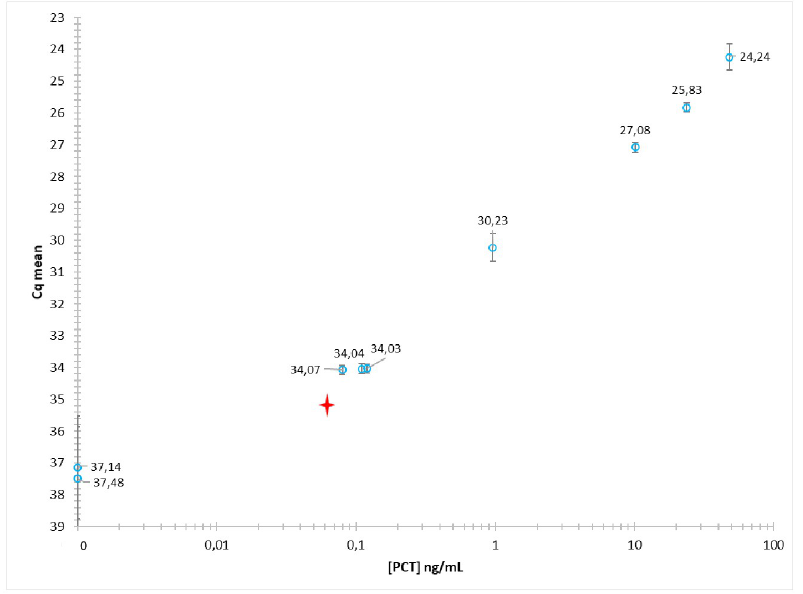
Fig 8. Short PEA protocol implemented on human plasma specimens containing different concentrations of PCT. The results, given in Cq values, correspond to the mean of two or three duplicate experiments. The red star corresponds to an estimation of the